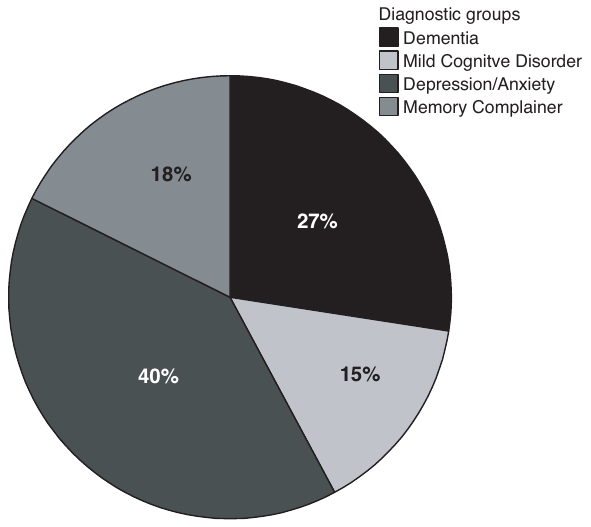
Graphic 2. Percentage of diagnosis divided into four groups (n=102).